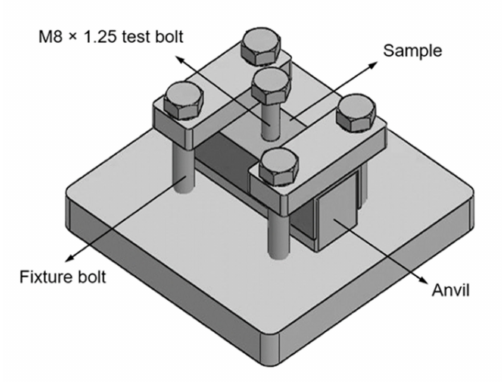
Figure 3. Model of the test rig fixture.